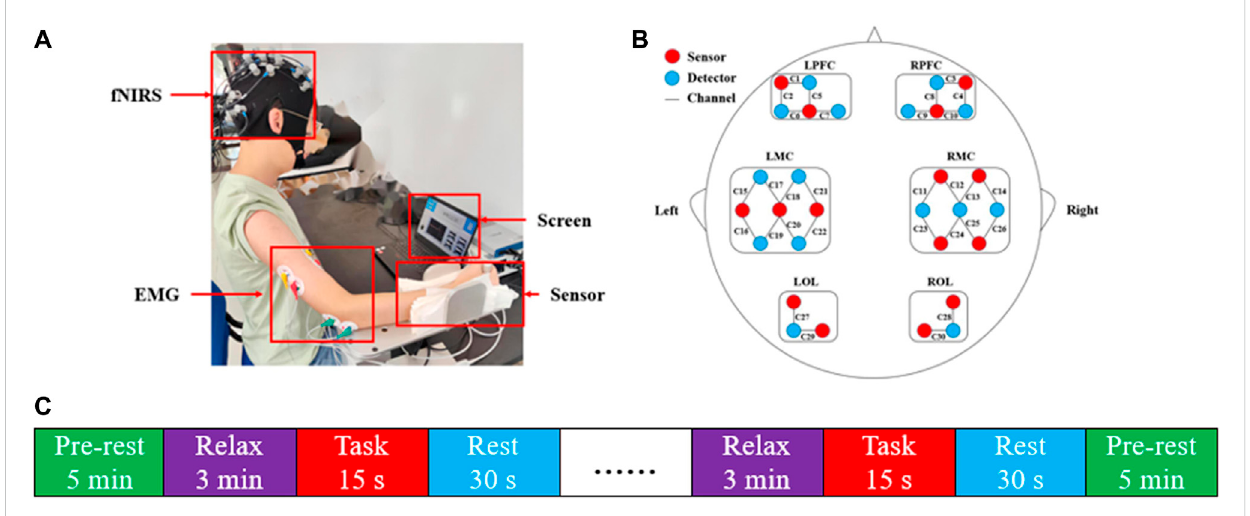
FIGURE 1 Theexperimentaldesignoftheevaluationtest. (A) Experimentalset-up. (B) Thelayout offNIRSchannels.Thereddotsrepresentedsources, andthe blue dots represented detectors. The 15 sources and 15 detectors constitute 30 channels, overlaying six brain regions: LPFC, RPFC, LMC, RMC, LOL, and ROL. (C) Experiment procedure. Each trial consisted of a combination of a 15 s task and a 30 s rest and was repeated fi ve times in each